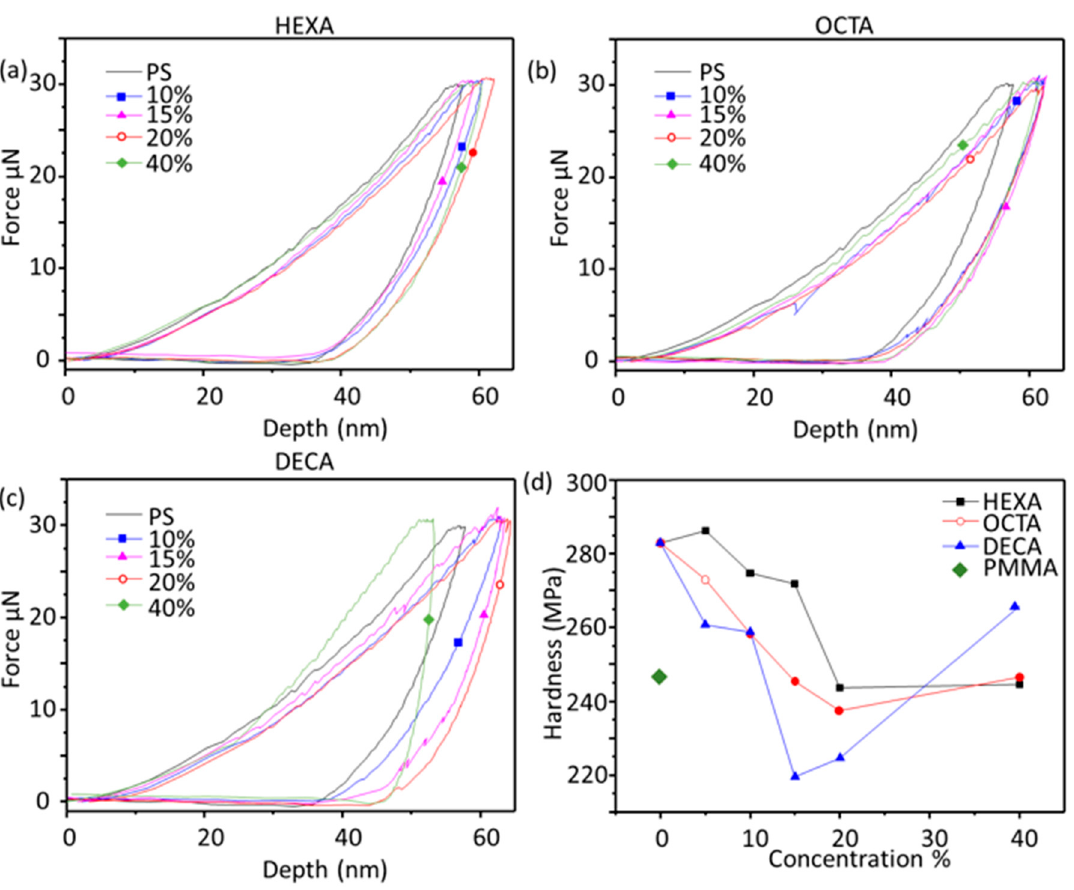
Figure 3. Nanoindentation and film hardness measurements for thin film. ( a ) Polystyrene + Hexadiene; ( b ) Polystyrene + Octadiene; ( c ) Polystyrene + Decadiene; ( d ) Comparison of Young’s modulus.